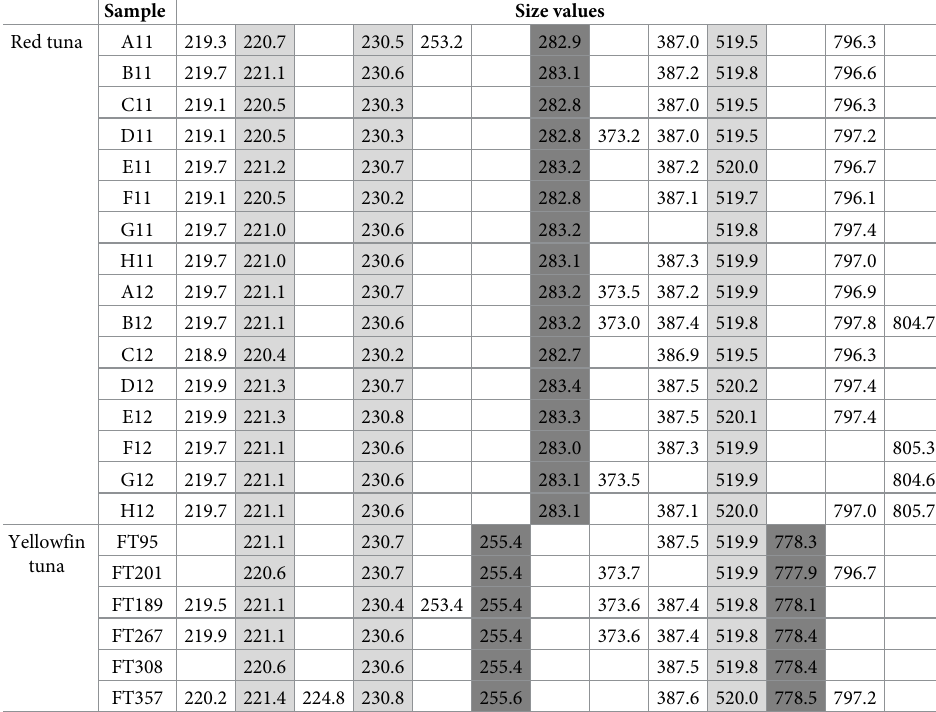
Table 3. aTBP profiles of tunafish ( Thunnus spp.).